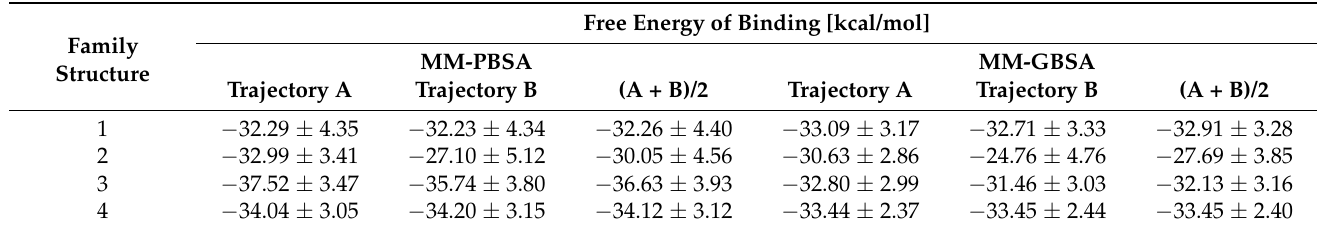
Table 6. MM-PBSA and MM-GBSA results of calculations for compound 1 /DNA binary complex.